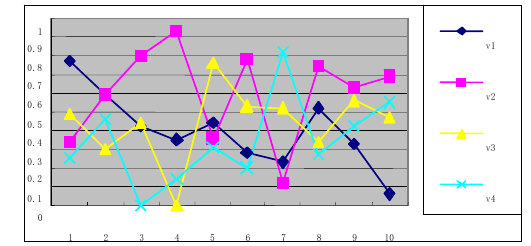
Fig.3. Optimal projection directions of the ten